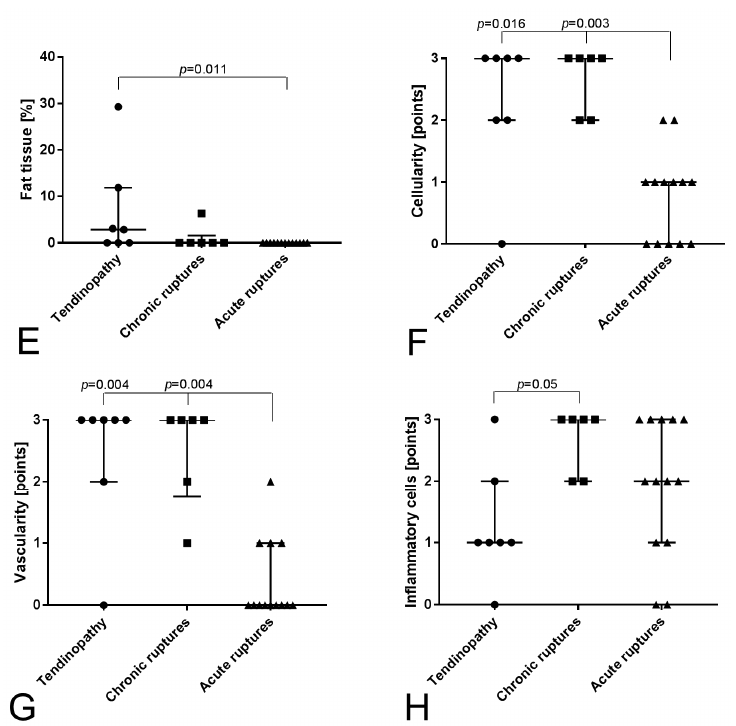
Figure 2. Evaluation of histological score: ( A ) Total histological score reaching 18 points as maximum, which would indicate a highly degenerated tendon. ( B ) Tendon architecture as indicator for the disturbance of the tendon structure (0–3 points). ( C ) Amount of aligned collagen quantified using ImageJ (0–100%). ( D ) GAG content (0–3 points, MP staining). ( E ) Fat tissue quantified using ImageJ (0–100%, MP staining). ( F ) Cellularity (0–3 points, HE staining). ( G ) Vascularity (0–3 points, α SMA staining). ( H ) Inflammatory cells (not included in histological score, CD45 staining). Data are given as individual dot plots with median and interquartile range.